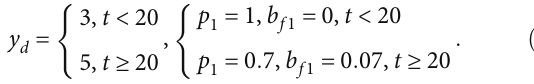
Figure 9: Tracking error e